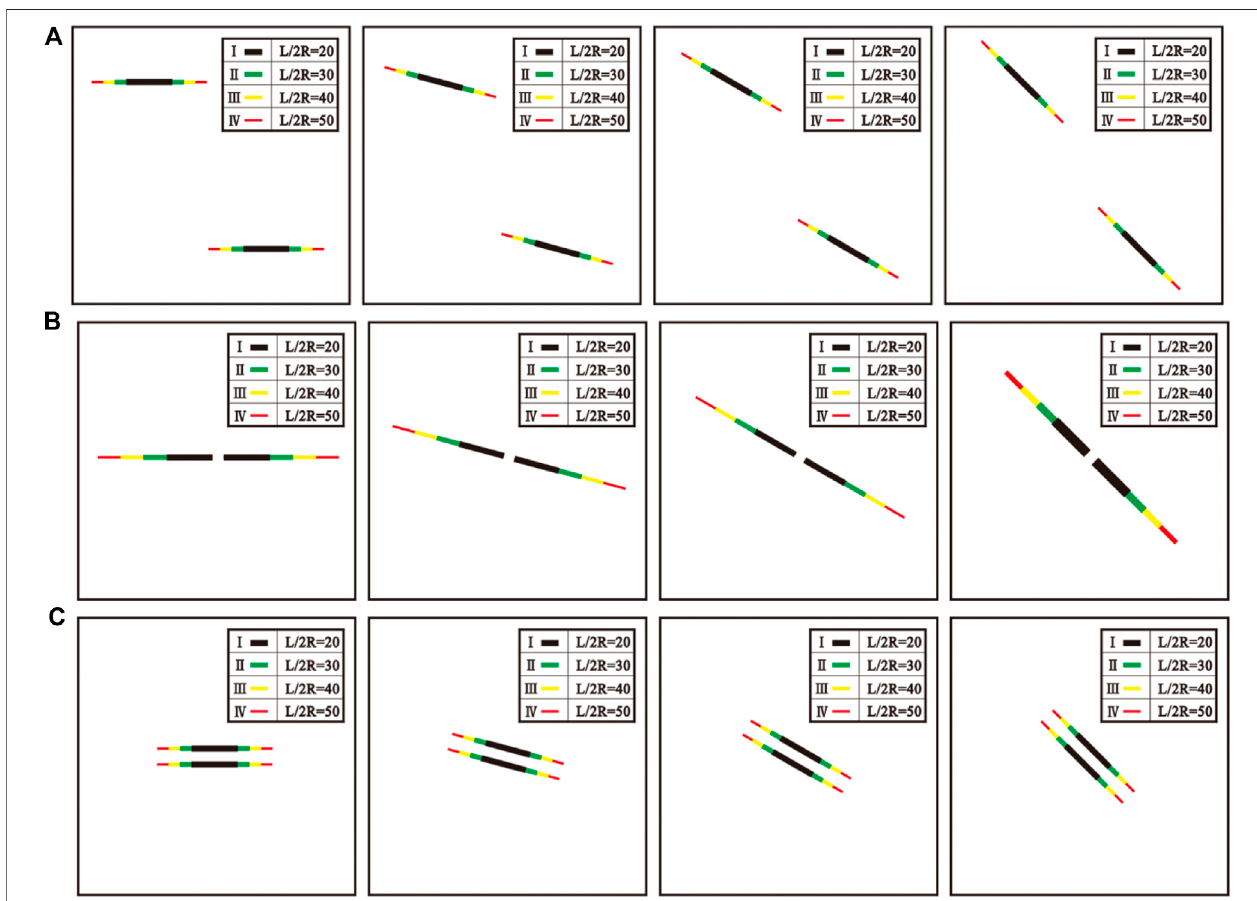
FIGURE 9 | Three types of spatial arrangements of double cracks with different lengths (20, 30,40, and 50 mm) and dip angles (0 ° , 15 ° , 30 ° , and 45 ° ). (A) Distant double cracks. (B) Collinear double cracks. (C) Stacked double cracks.